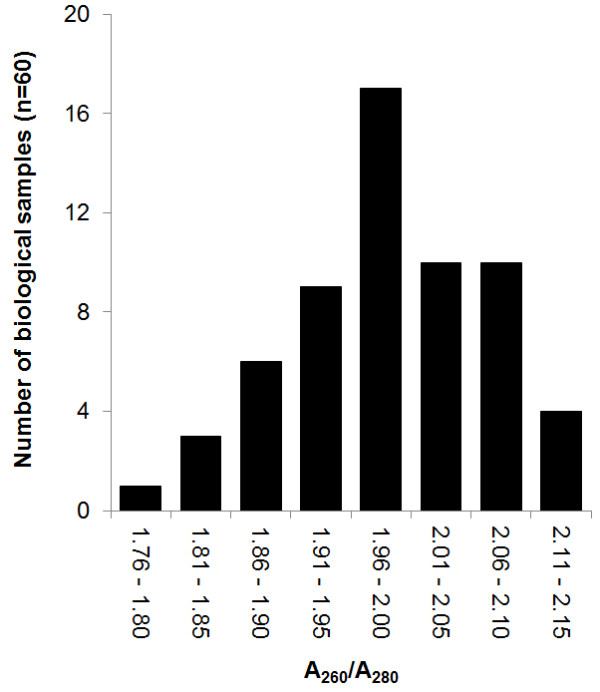
RNA purity: A260/A280. Purity of RNA was measured using the ratio of absorbance at 260 nm/absorbance at 280 nm. X- axis shows the intervals of A260/A280 for the 60 biological samples from the time course experiments.